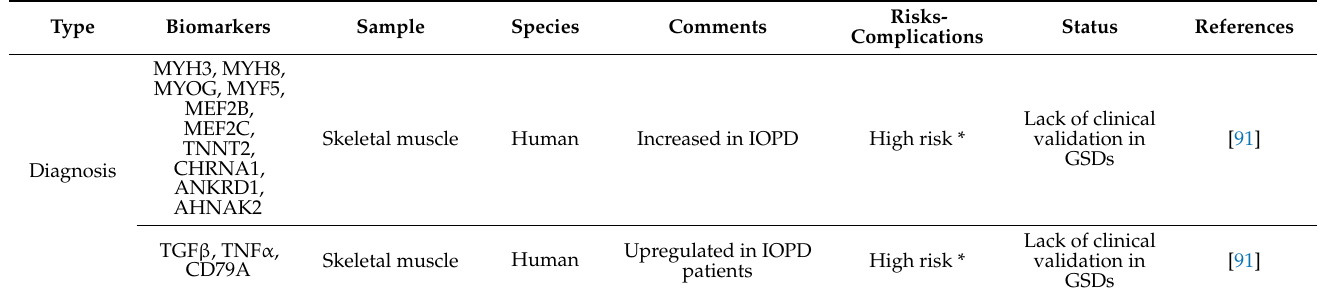
Table 3. Set of putative biomarkers in